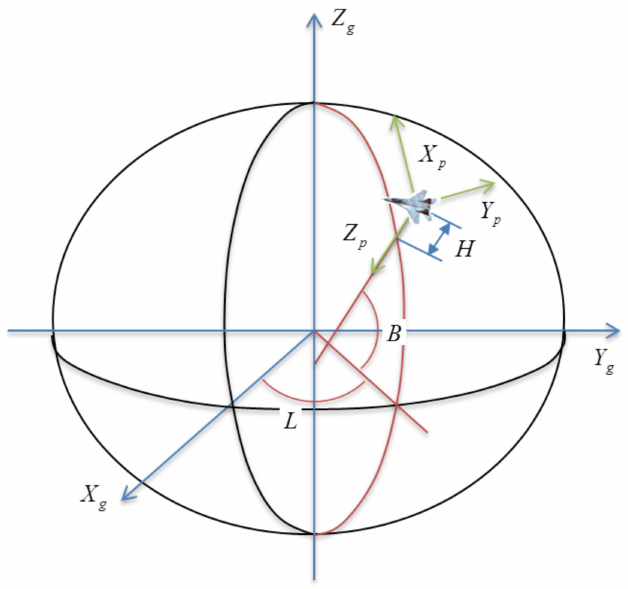
Figure 5. The geodetic coordinate frame and the navigation coordinate